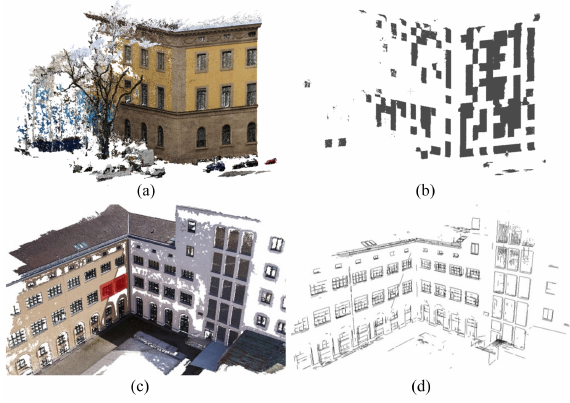
Figure 4. (a) Point cloud and (b) extracted planar primitives.(c) Point cloud and (d) corresponding linear